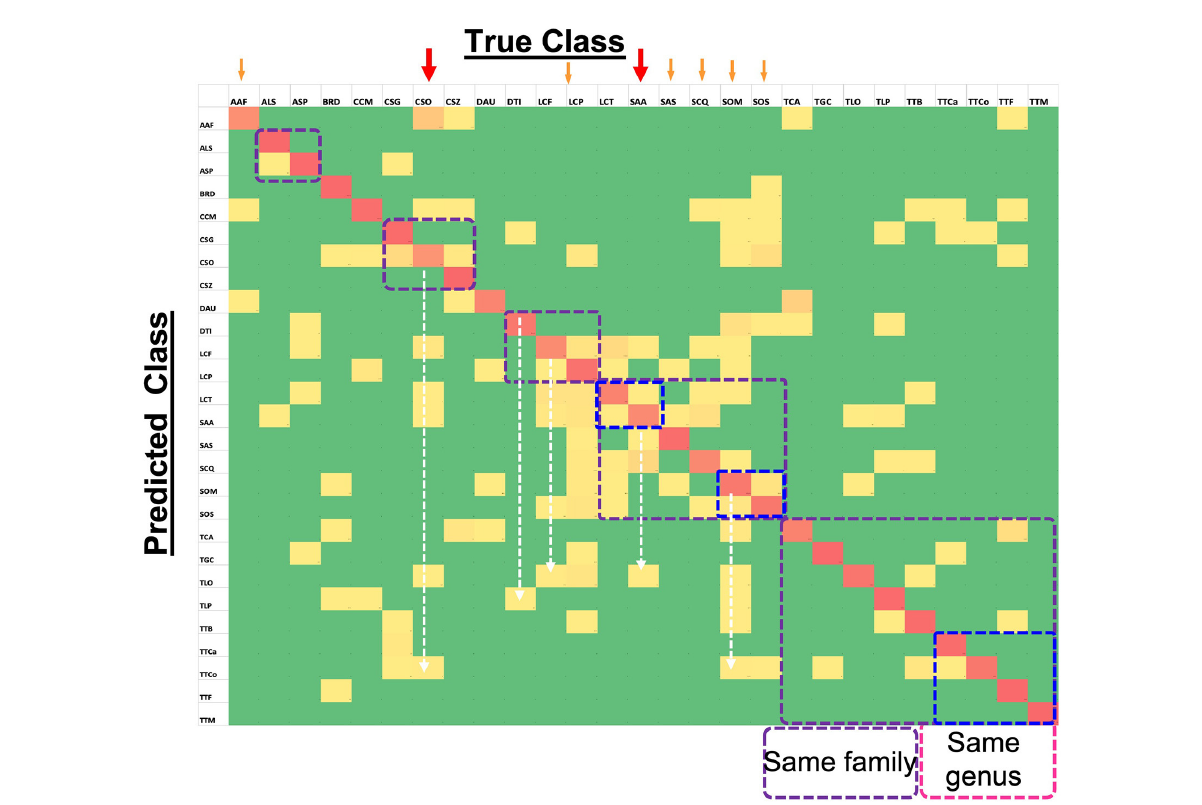
FIGURE5 Confusion Matrix for 27-class task (computed on test set) showing the level of agreement between true and predicted classes. Red colored tiles (diagonal) represent correct classification of each species and represent values between 67% and 100%. Yellow tiles represent incorrect classification ratios that are non-zero and go up to 28%. Finally, green tiles represent zero values which means targeted species is not confused with the corresponding